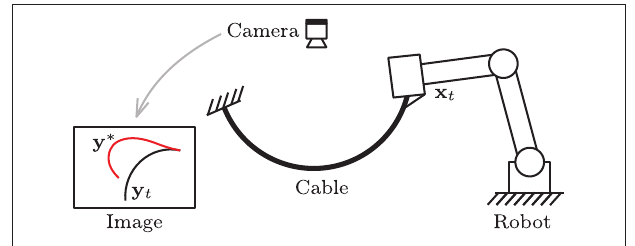
FIGURE 3 | Representation of the cable manipulation case of study, where a vision sensor continuously measures the cable’s feedback shape y t , which must be actively deformed toward y ∗ .